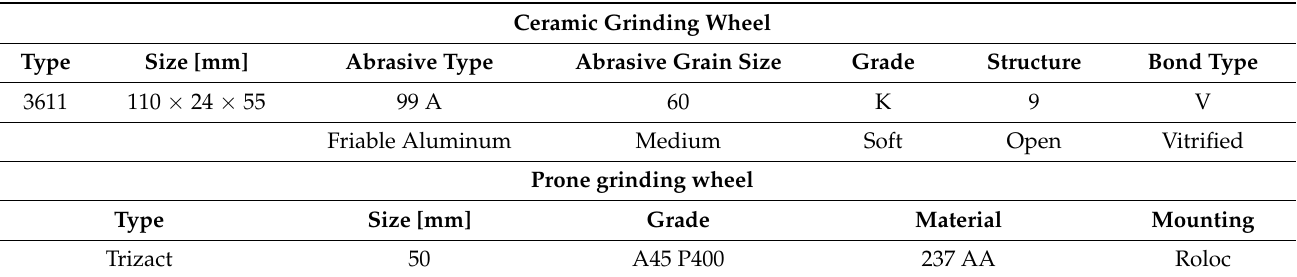
Table 1. Characteristic of grinding wheels.